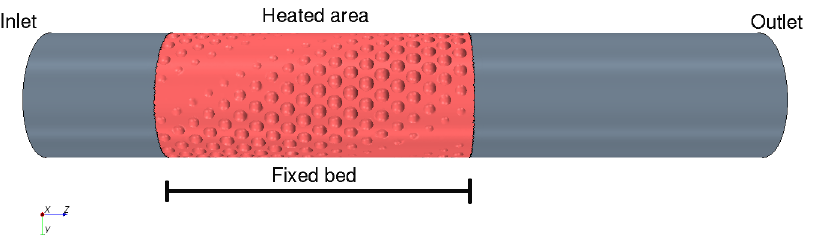
Figure 2. Reactor geometry overview for a particle diameter ratio of D / d p = 8.8: flow direction is from left to right. The red zone marks the heating area (constant temperature T wall = 373 K) as well as the fixed bed. The upstream and downstream extrusion to minimize the influence of the inlet and outlet boundary condition is shown in